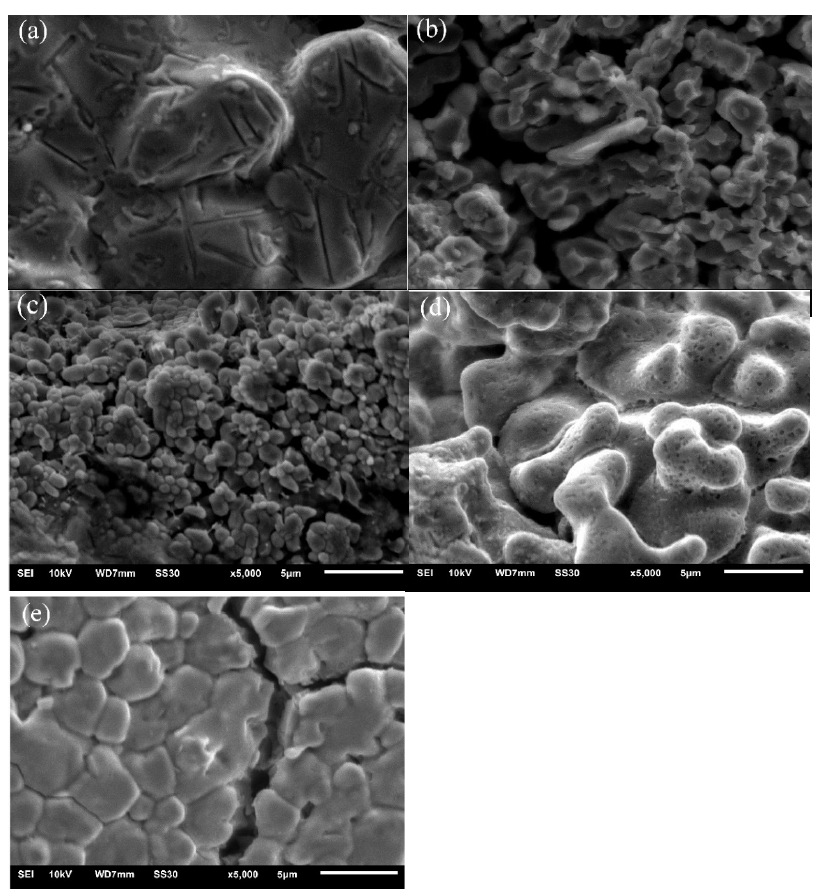
Figure 4. Structures of the different batches soaked in 5 mol/L NaOH solution at 40 °C for 2 h. ( a ) Batch 1 (Ni:Al–CoCrMo = 1:1). ( b ) Batch 2 (Ni:Al–CoCrMo = 1:1.5). ( c ) Batch 3 (Ni:Al–CoCrMo =